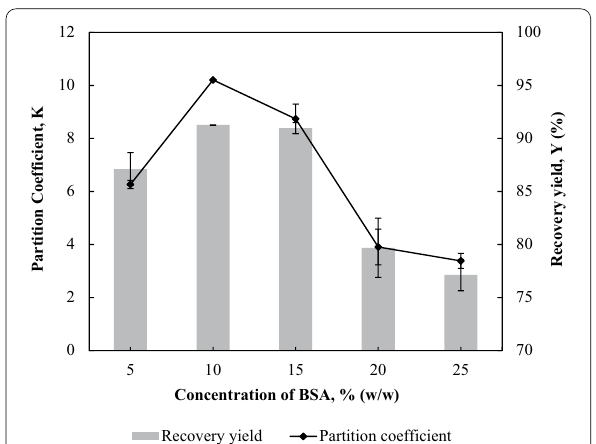
Fig. 3 Effect of amount of BSA added to the ABS on the partition efficiency of BSA. The amount of BSA was varied at a range of 5–25% (w/w) to evaluate the effect of protein concentration on the K and Y of BSA in the 35% (w/w) 1‑propanol/22% (w/w) maltose ABS. The results are expressed as mean standard deviation of triplicate ± readings